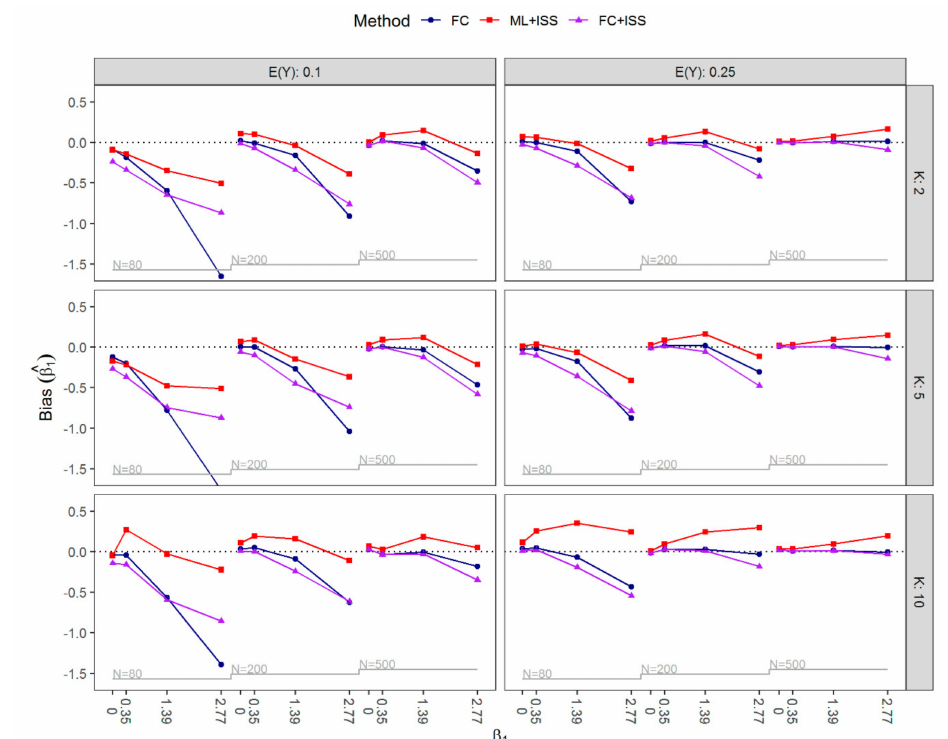
Figure 2. Nested loop plot of bias of ˆ β 1 by the expected value of Y , E ( Y ) ∈ { 0.1, 0.25 } , the number of covariates K ∈ { 2, 5, 10 } , the value of β 1 ∈ { 0, 0.35, 1.39, 2.77 } , and the sample size N ∈ { 80, 200, 500 } for all simulated scenarios. FC, Firth’s correction; ML + ISS, maximum likelihood combined with the increasing sample size approach; FC + ISS, Firth’s correction combined with the increasing sample size